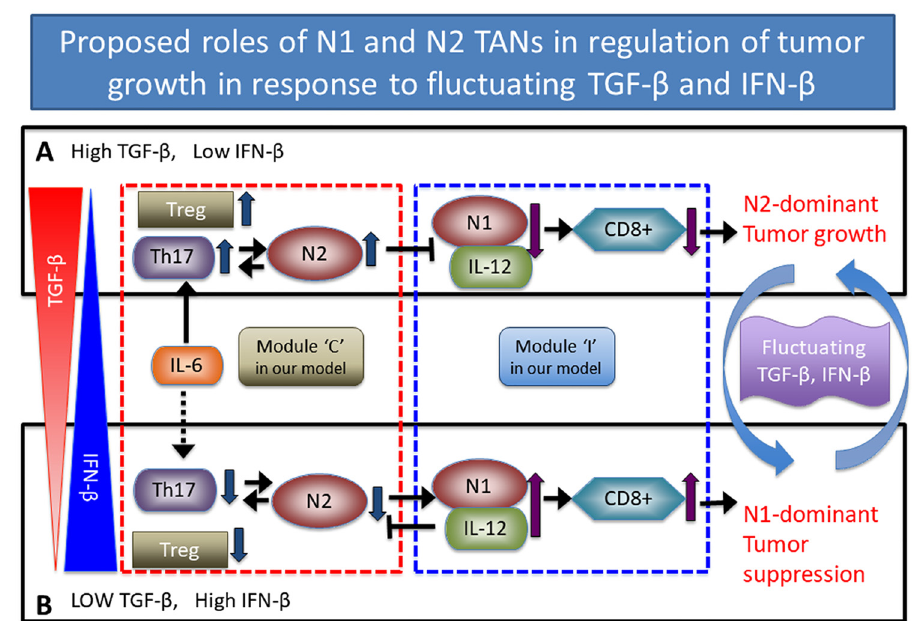
Fig 2. Proposed role of N1 and N2 complexes in the regulation of tumor growth and immune-suppression in response to fluctuating TGF- β and IFN- β . The phenotypic balance between N1 and N2 complexes determines tumor growth or suppression in response to TGF- β (red triangle on the left) and IFN- β (blue triangle on the left). (A) High TGF- β levels and low IFN- β activities induce Treg infiltration which in turn leads to biochemical suppression of the overall anti-tumor immune activities of T cells. TGF- β also modifies the tumor microenvironment by transforming N1 into N2 TANs [8, 34] while IFN- β brings the N2 phenotype back to the N1 phenotype [8]. This N2-dominant microenvironment leads to enhanced tumor growth. (B) Low TGF- β levels and upregulation of IFN- β reduce the phenotypical transition from N1 to N2 TANs and leads to upregulation of immune activities of T cells and N1 TANs, leading to suppression of tumor growth. Schematic components of the N2/Th17/Treg complex and the N1/IL12/CD8+ complex are represented by modules ‘C’ (box with the red dotted line) and ‘I’ (box with the blue dotted line) in our theoretical framework. Blue arrows on the right indicate the switching behavior between a tumor-promoting mode in (A) and the tumor-suppressive state in (B) in response to fluctuating TGF- β and IFN- β levels.